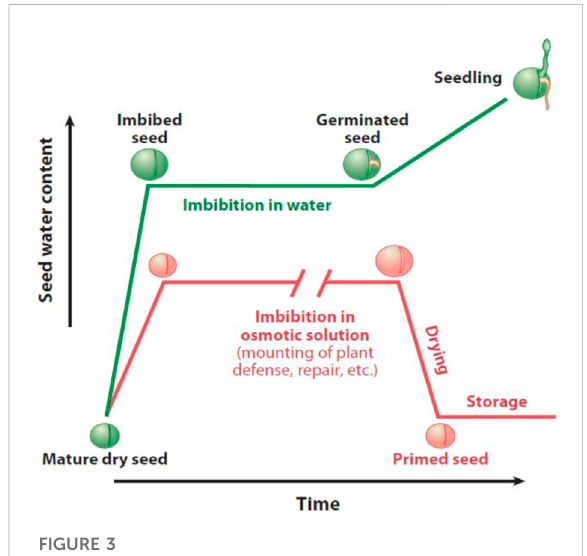
FIGURE 3 Graphical demonstration of the water uptake inside the seed intheseedprimingprocessandstandardgermination(Rajjouetal.,